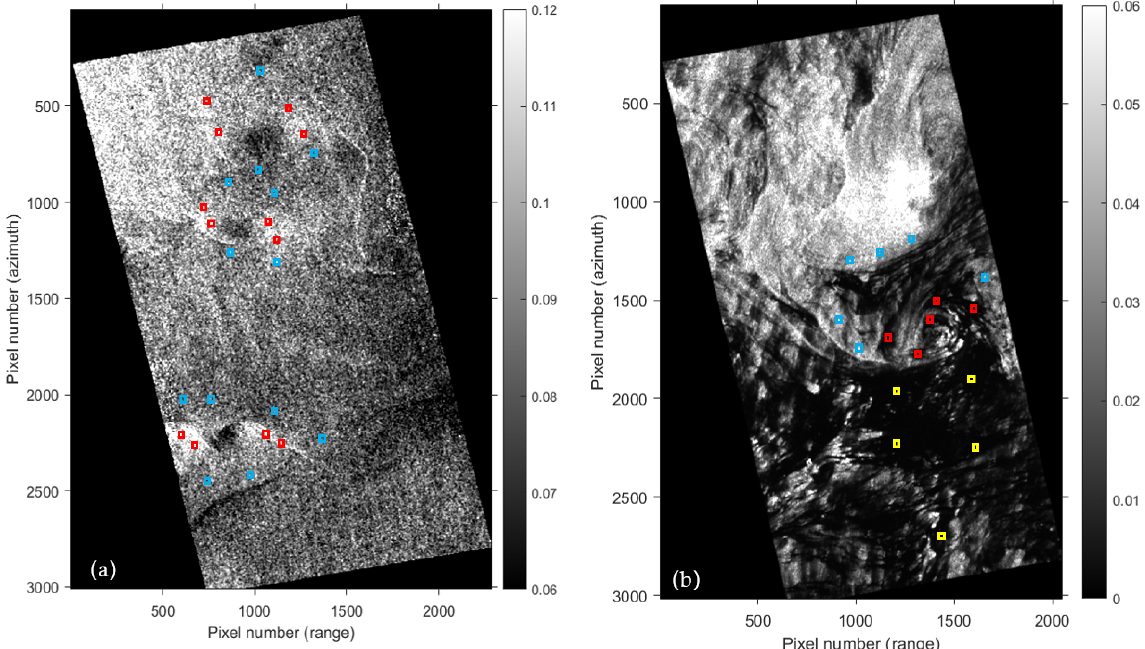
Figure 4. Regions of interest used in the analysis. The red, blue, and yellow boxes indicate the eddy outline, ocean back- ground, and oil film, respectively. ( a ) Data #A. ( b ) Data #B. The size of the boxes is 50 × 50 pixels.